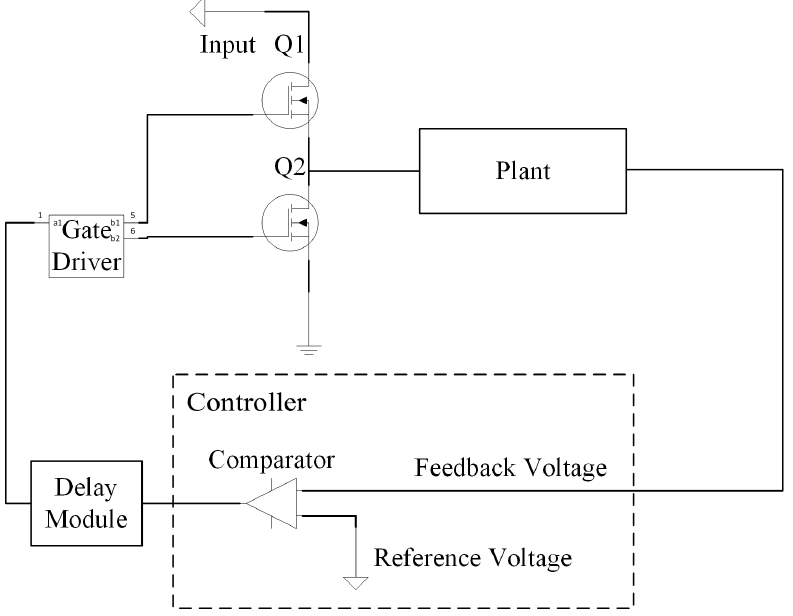
Figure 1. The block diagram of Algorithm